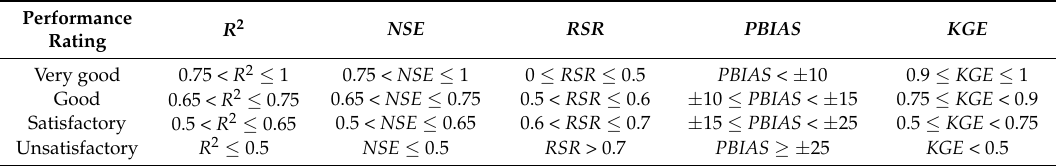
Table 4. General performance ratings for a monthly time step